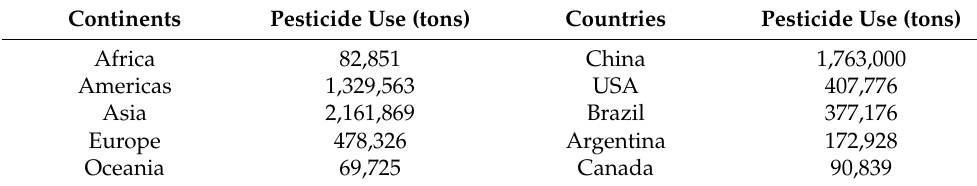
Table 1. Pesticide use per continent and pesticide use in the top 5 countries [15]. Continents Pesticide Use